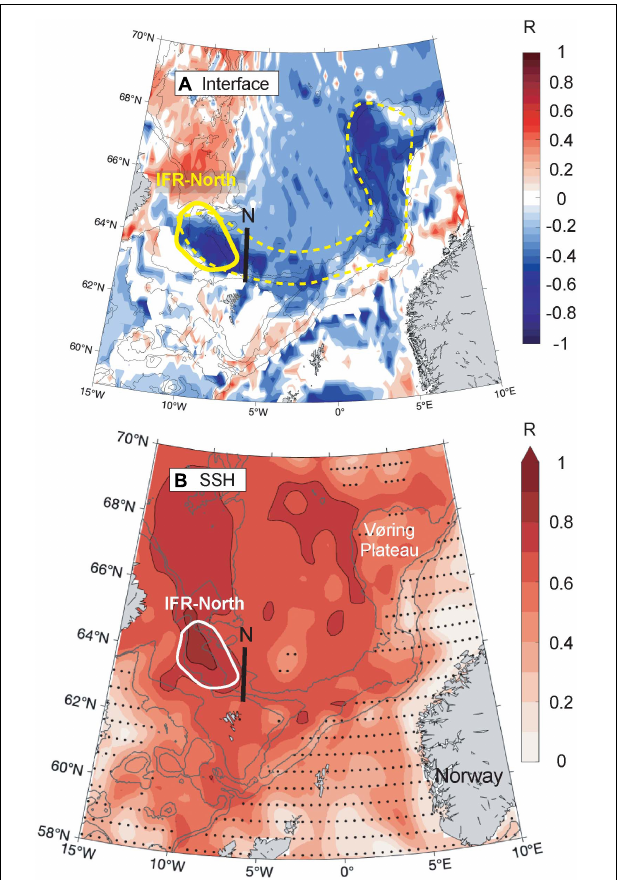
FIGURE 8 | A broader view. Correlation maps between the FBCO transport and (A) the height of the 3 ◦ C isotherm (see section “Large-Scale Data Collection”) and (B) the sea-surface height field (SSH) from satellite altimetry. The correlation of the interface in the upper panel is based on annual mean data, while a 360-day running mean is used for the SSHs in the lower panel. Because of the time smoothing, the dotted regions in the lower panel indicate non-significant correlations based on the number of effective degrees of freedom (Pyper and Peterman, 1998). The position of standard hydrographic section N is shown with black lines, and the yellow/white outline in (A,B) marks the IFR-North region, from where the SSH time series in Figure 9 is extracted. The horseshoe-shaped band is illustrated with the dashed yellow outline in (A)